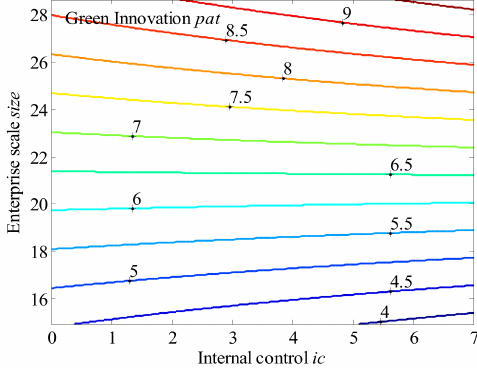
Figure 3. Regulatory effect of enterprise scale.